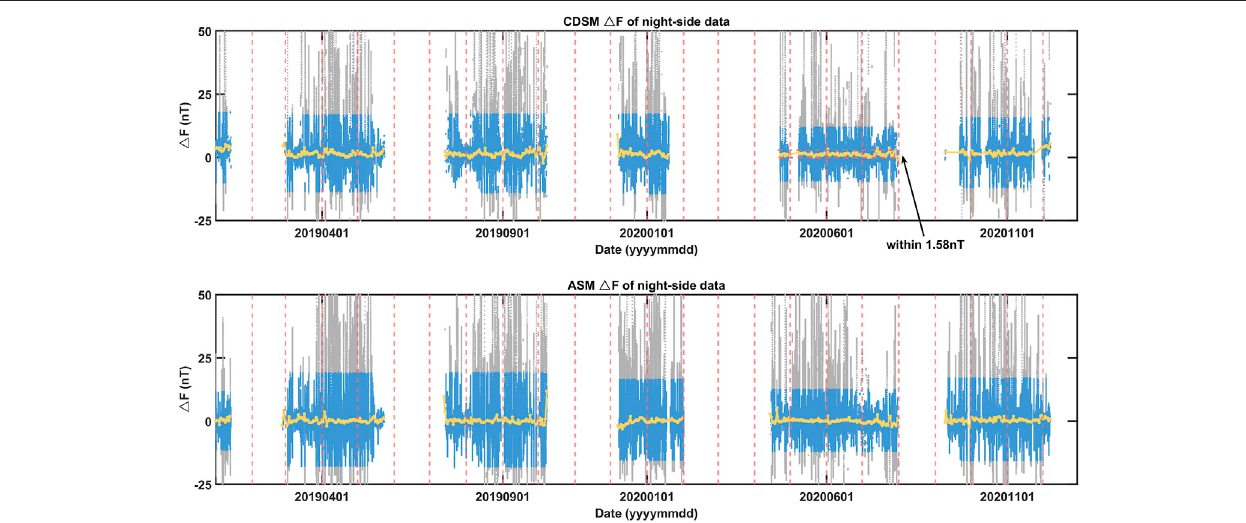
FIGURE14| StatisticalresultsofthedifferencebetweentheCDSM/ASMandCHAOSusingselecteddatafrom2019to2020(graypointsrepresentthe Δ F ofevery data point excluded by the 3 sigma criterion, blue points represent the Δ F of points restricted with the 3 sigma criterion in night-side orbits, and yellow points represent the average daily Δ F of night-side data points restricted with 3 sigma